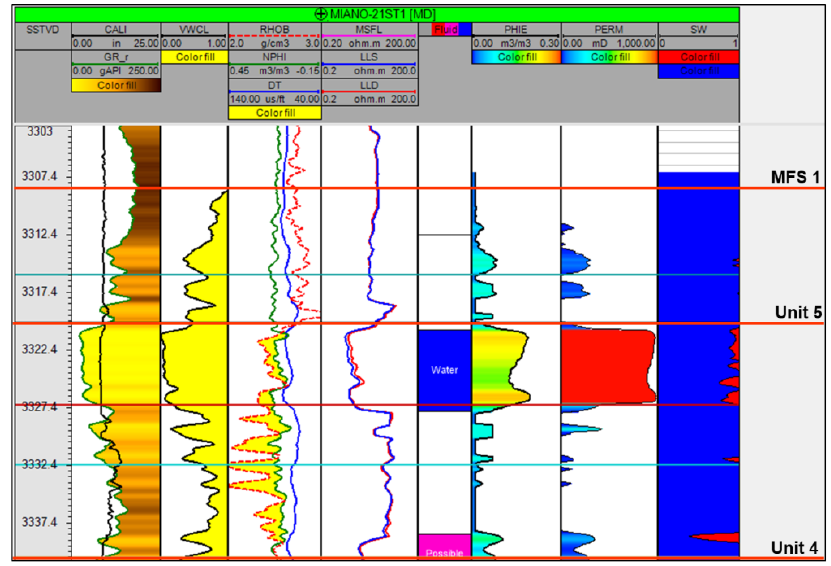
Figure 23. The well where the free water level is identified. Well log interpretation indicates that the top of the free water level is at -3320 m SSTVD.